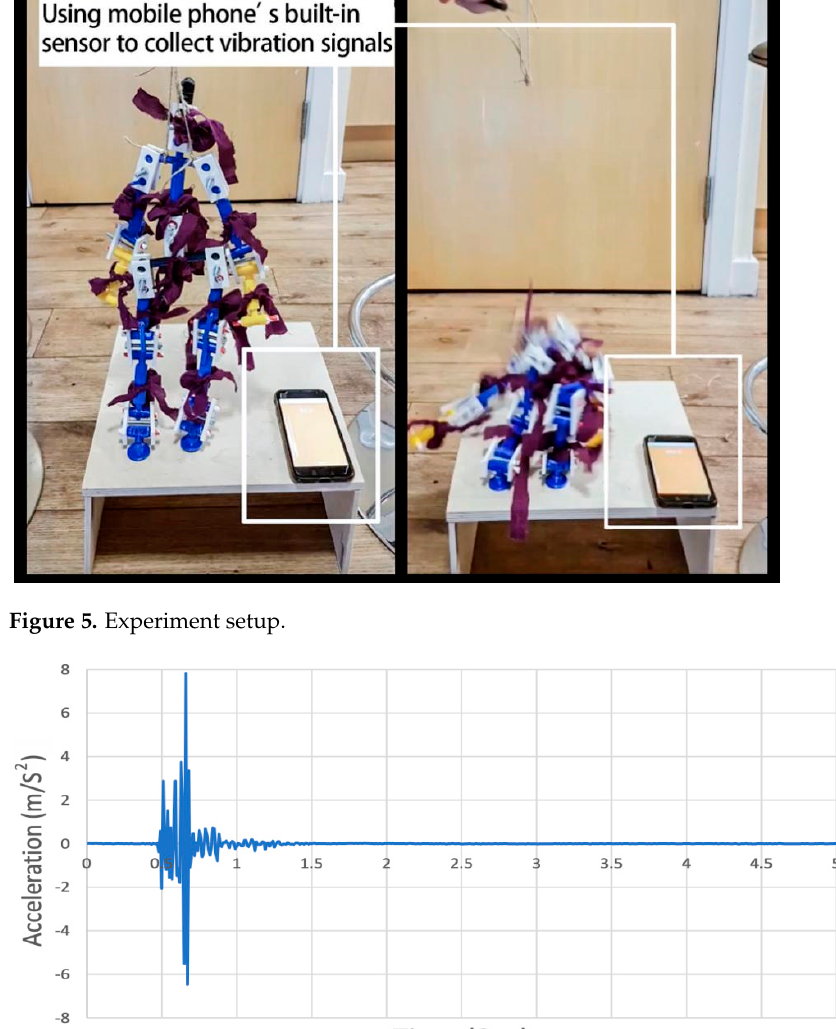
Figure 6. Time-history record for human fall.